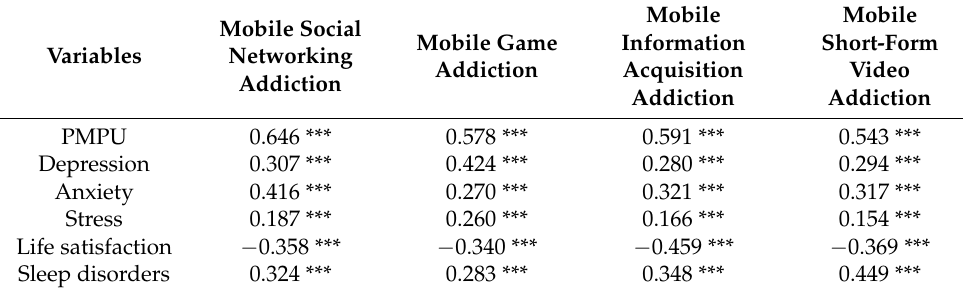
Table 3. Results of the convergent validity and criterion-related validity test.